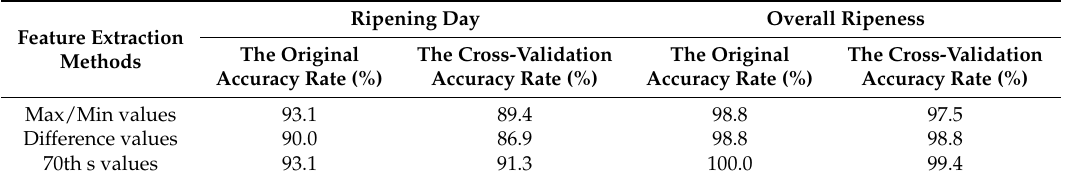
Table 5. Results of the discrimination by LDA based on three different feature extraction methods.